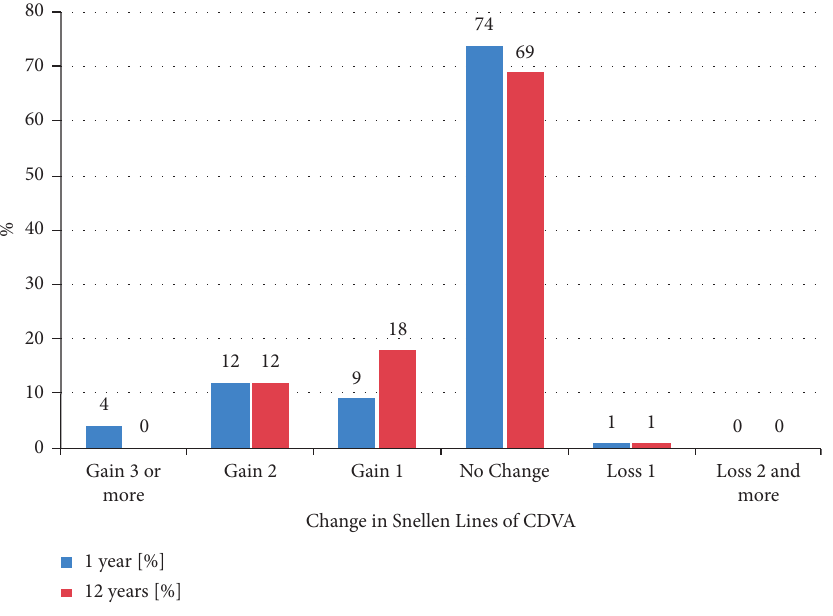
Figure 2: Change in corrected distance visual acuity. Table 5: Intraocular